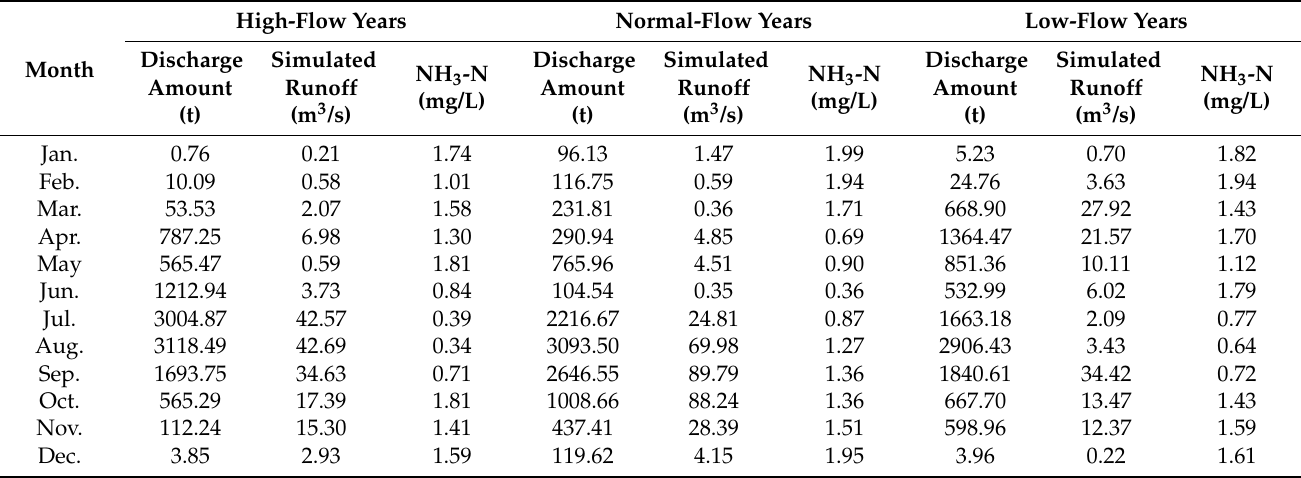
Table 7. Pollutant discharge amount and NH 3 -N concentration after